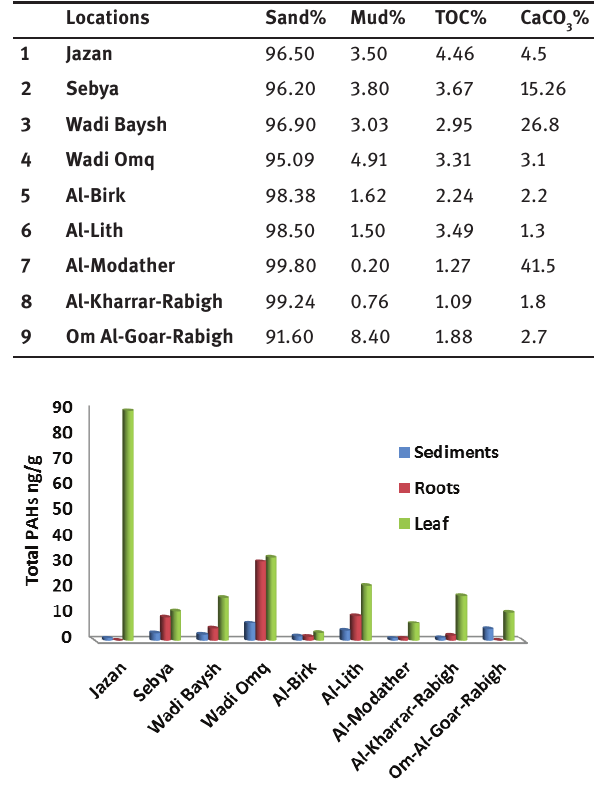
Figure 2: Total PAH concentrations (ng/g) for sediment, roots and leaf in the nine sites of the studied mangrove